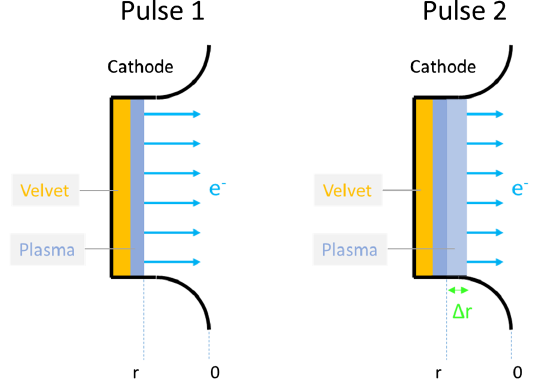
FIG. 8. Schemes of the evolution of the plasma boundary for the first pulse (left part of the figure) and for the second pulse (right part of the figure). Δ r corresponds to the difference between the recess at the first and at the second pulse. FIG. 9. Evolution of Δ r with Δ t ranging from 100 ns to 3 μ